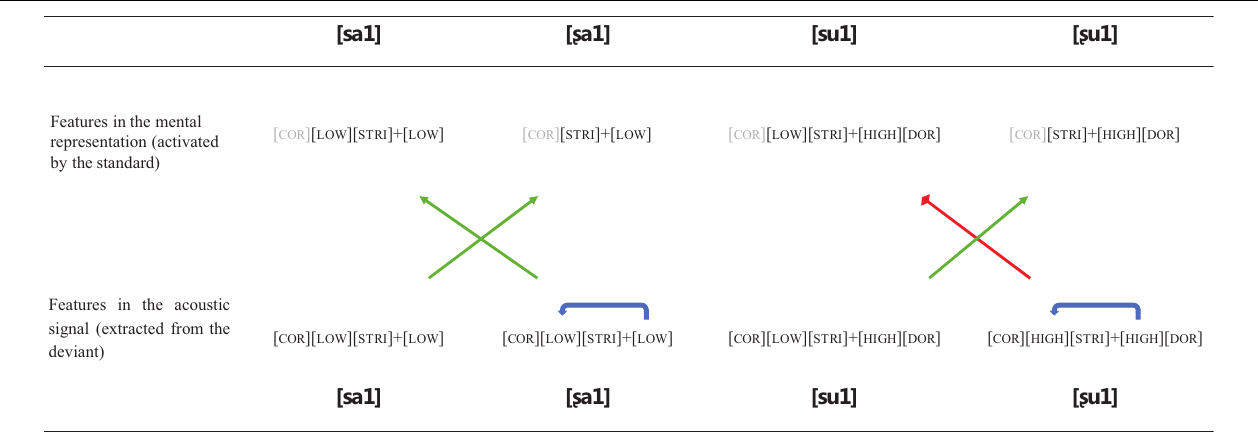
FIGURE 2 | Predictions made about the feature conflict in the four experimental conditions. The arrows illustrate the main statistical model. The blue arrow reflects the feature spread on the surface from vowel to consonant. The green arrows indicate combinations of standard and deviant stimuli in no-mismatch conditions and the red arrow represents the mismatch